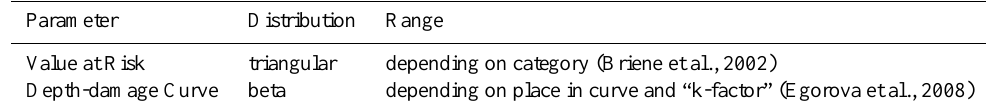
Table 3. Distribution and range of uncertainty estimates for parameters related to the damage calculation. Parameter Distribution Range Value at Risk triangular depending on category (Briene et al., 2002) Depth-damage Curve beta depending on place in curve and “k-factor” (Egorova et al., 2008)